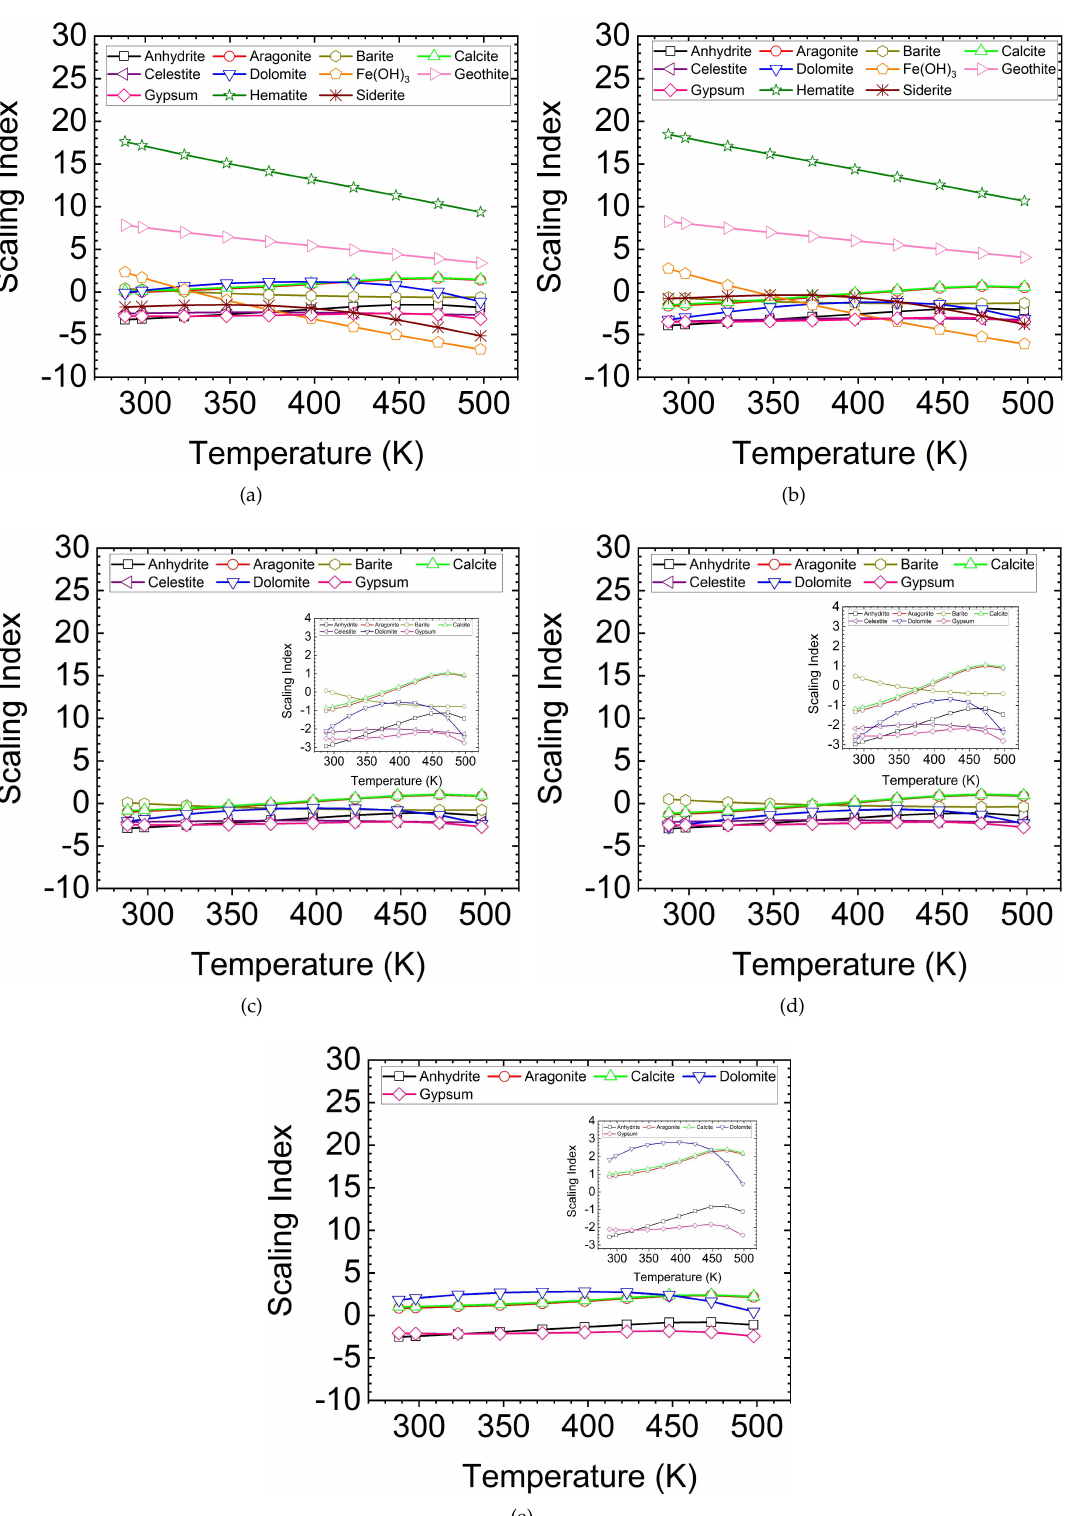
Figure 3. Scaling Index versus temperature for ( a ) well A, ( b ) well B, ( c ) well C, ( d ) well D and ( e ) well E. The main scaling minerals for samples A and B are Fe 2 O 3 , α FeOOH and Fe(OH) 3 . Samples C and D are Fe-free samples. For these samples, CaCO 3 can precipitate. CaMg(CO 3 ) 2 can precipitate from sample E when T < 398